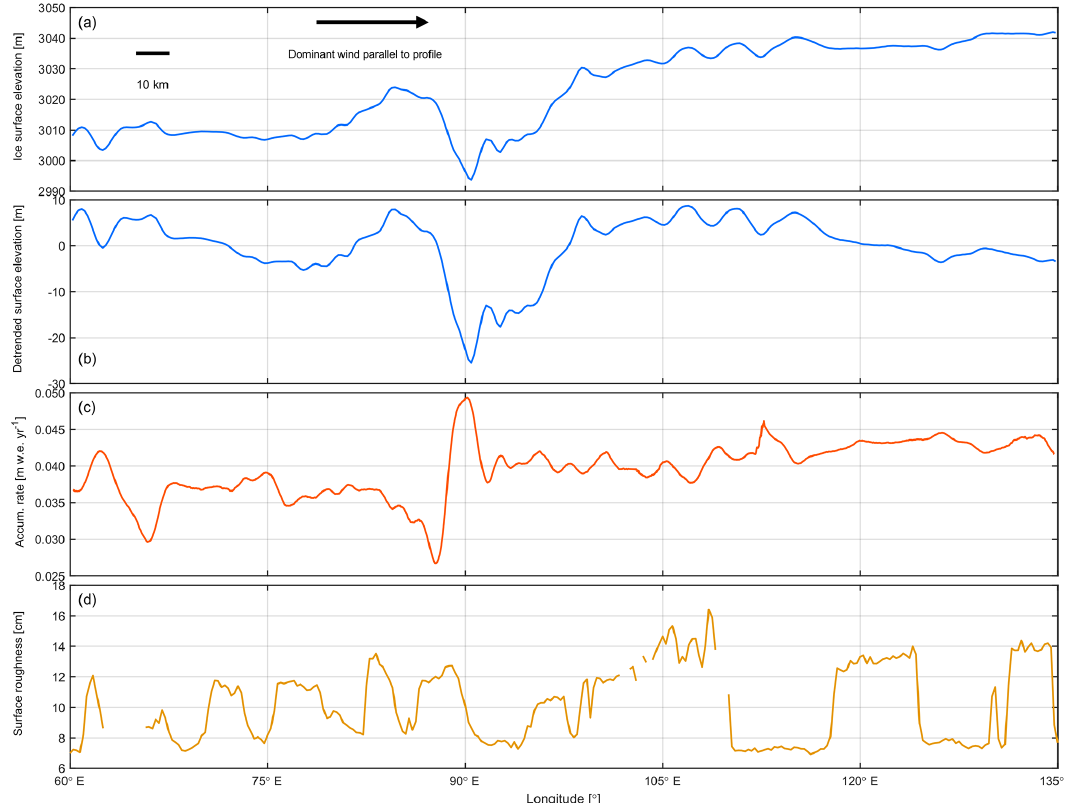
Figure A3. (a) Ice surface elevation between 60 and 135 ◦ E from ATM laser altimetry. The dominant wind direction from MERRA-2 is parallel to the profile segment. (b) Ice surface elevation with linear trend removed. (c) Snow accumulation rate where the pronounced peak at 90 ◦ E corresponds to the topographic depression in the ice surface. (d) ATM-derived ice surface roughness.